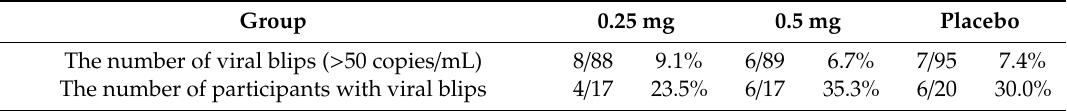
Table 3. Data on viral load increases registered in trial